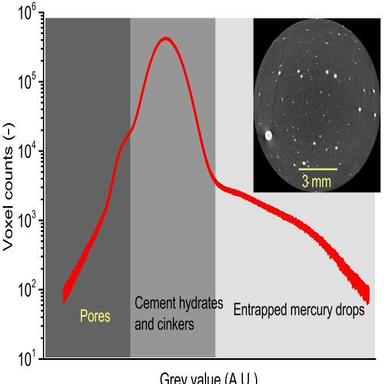
GVD plot of P03-30 sample with three identified phases (pores, cement hydrates and clinkers, and entrapped mercury drops) and a horizontal cross section view of the same sample (inserted panel).